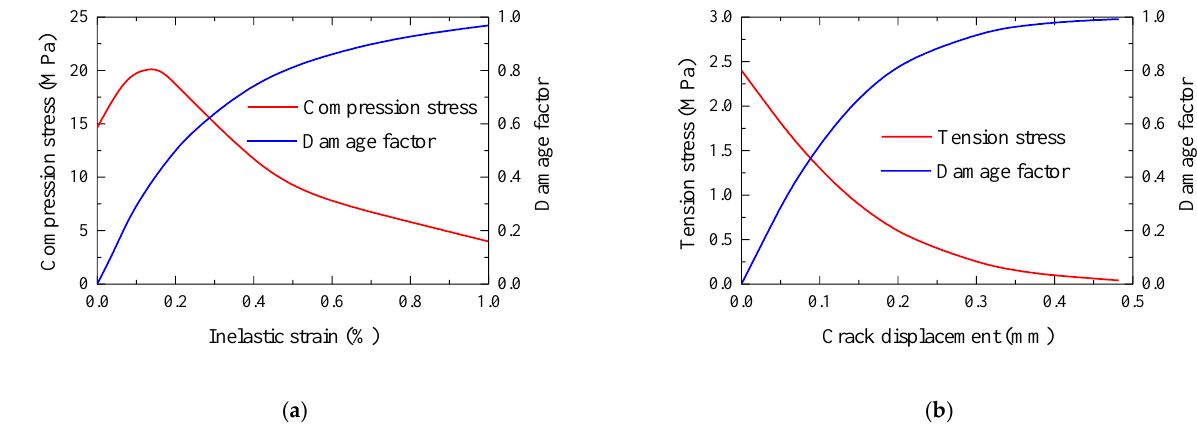
Figure 5. Finite element models of central columns: ( a ) Original station; ( b ) Original tunnel; ( c ) New station.